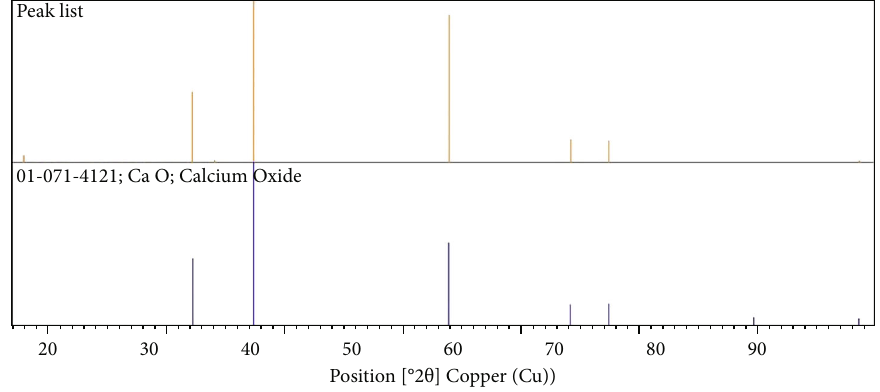
Figure 6: Peak list of CaO and the reference sample.